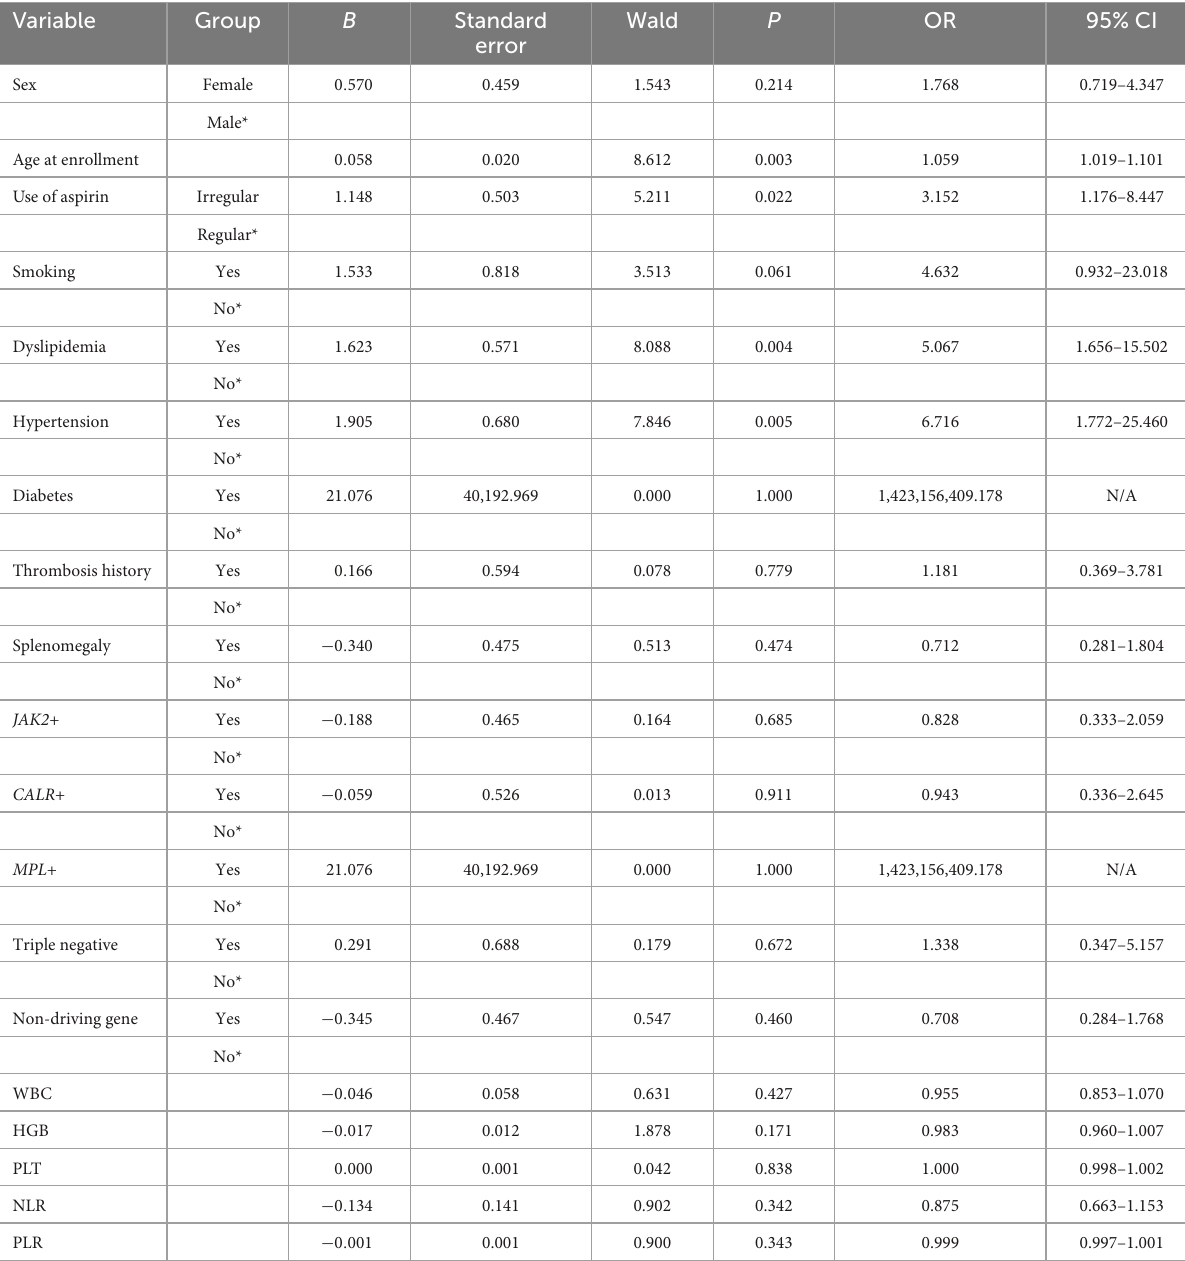
TABLE 3 Univariate logistic regression analysis of